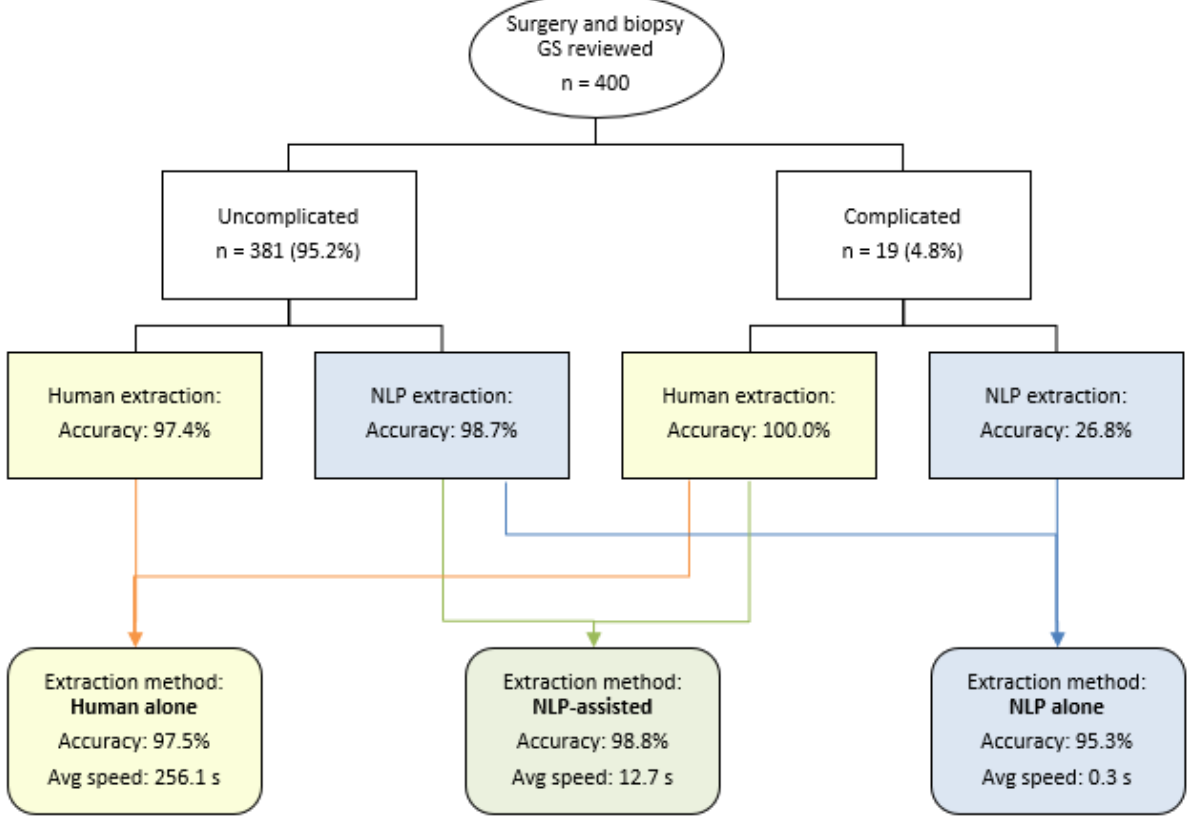
Figure 4. Accuracy and average extraction time for the three extraction